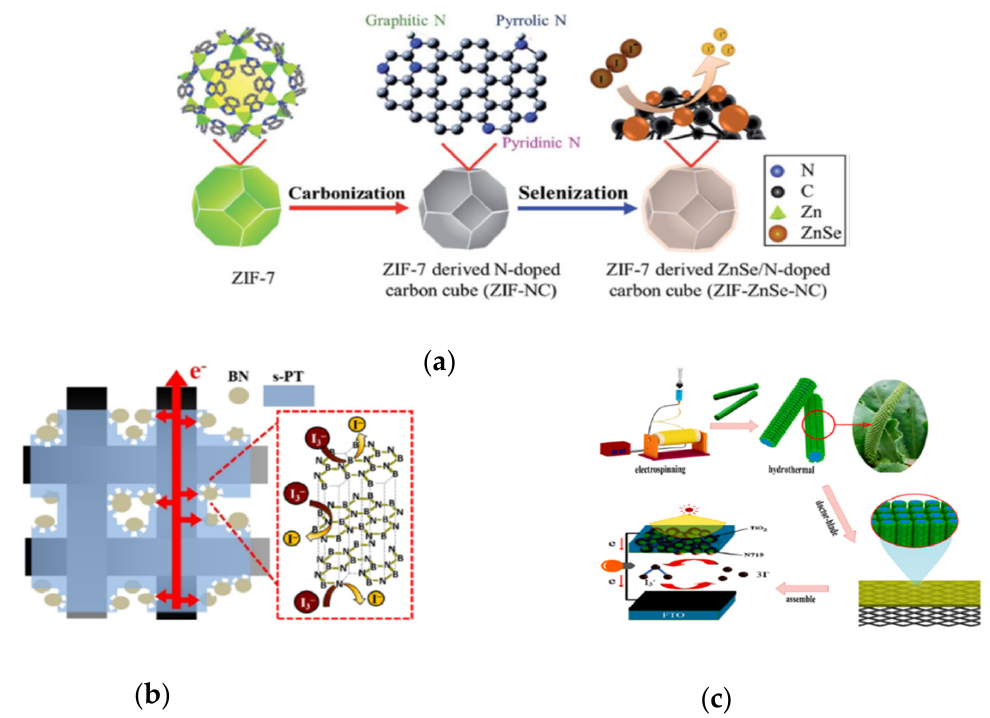
Figure 10. ( a ) The sketch of the process from ZIF-7 to ZIF-derived materials [86]. ( b ) Sketch of the electron transfer phenomenon in BN/s-PT-50 electrode [87]. ( c ) The fabrication process of a dye-sensitized solar cells with the Bi 2 MoO 6 /CNFs composite [89].